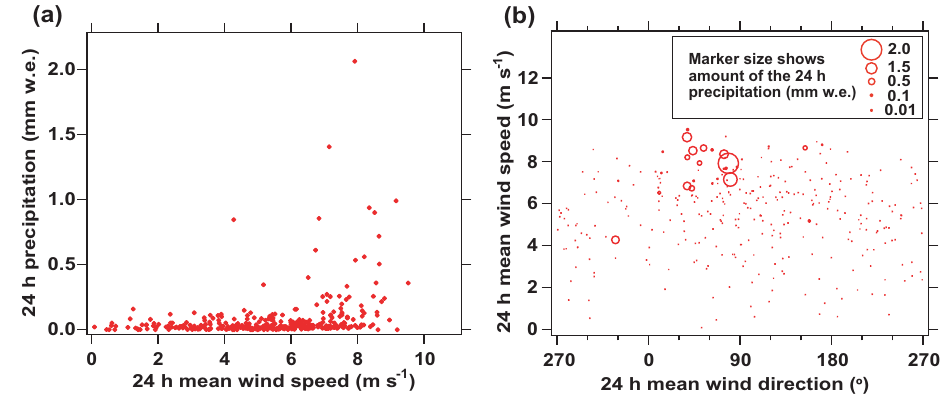
Fig. 11. Relation between high-precipitation events and strong-wind events at Dome Fuji Station in a period from February 2003 to January 2004. The amount of precipitation each 24 hours was measured (Fujita and Abe, 2006). Wind speed and direction was measured at a height of 10 m above the ground (Japan Meteorological Agency, 2005). Each data point represents an average over 24 h. Correlations were then investigated. (a) Relation between 24-h precipitation (in mm, water equivalent) and 24-h-mean wind speed. High-precipitation events are associated with strong-wind events in most cases. (b) Relation between 24-h-mean wind speed (same as in (a)) and 24-h-mean wind direction. Size of the marker represents the amount of precipitation. Most high-precipitation events occured with a limited range of wind direction centered at 55 ◦ (±25 ◦ ). This direction agrees well with the direction of the strongest winds (see Fig. 6b and Table